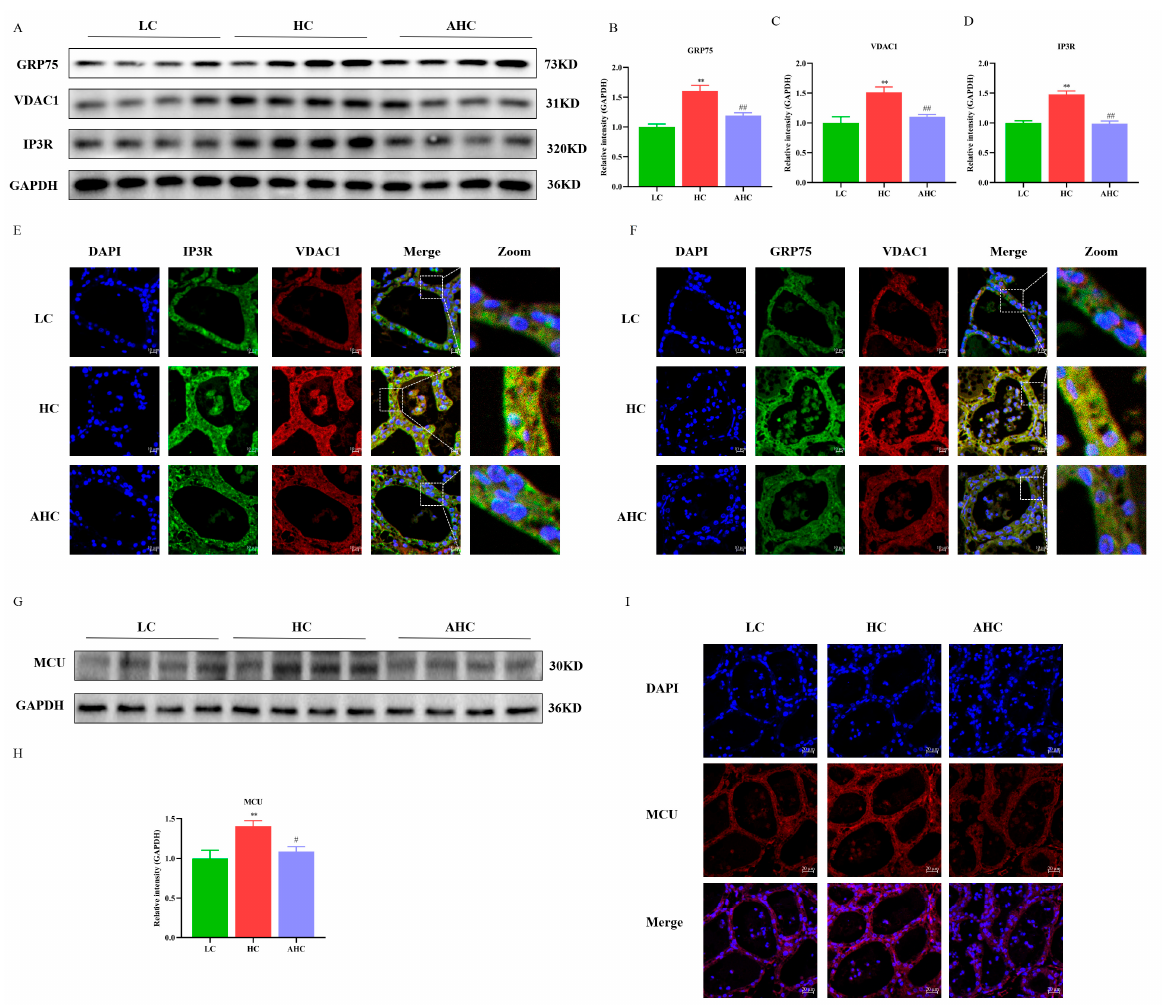
Figure 3. The effects of the high-concentrate diet supplemented with disodium fumarate on the IP3R-VDAC1-MCU of the mammary glands of Hu sheep. The protein expression of IP3R, GRP75, and VDAC1 in mammary gland tissue of Hu sheep ( A – D ); immunofluorescence results of IP3R, GRP75, and VDAC1 in the mammary tissue of Hu sheep. The bar = 10 µ m ( E , F ). The white line represents zooming in on the selected area of the image; the protein expression of MCU in the mammary gland tissue of Hu sheep ( G , H ); immunofluorescence results of MCU in the mammary gland tissue of Hu sheep. The bar = 20 µ m ( I ). Data are presented as the relative protein abundances relative to GAPDH (means ± SEM), ** p < 0.01 represents significant differences compared with the LC diet. # p < 0.05, ## p < 0.01 represent significant differences compared with the HC diet.